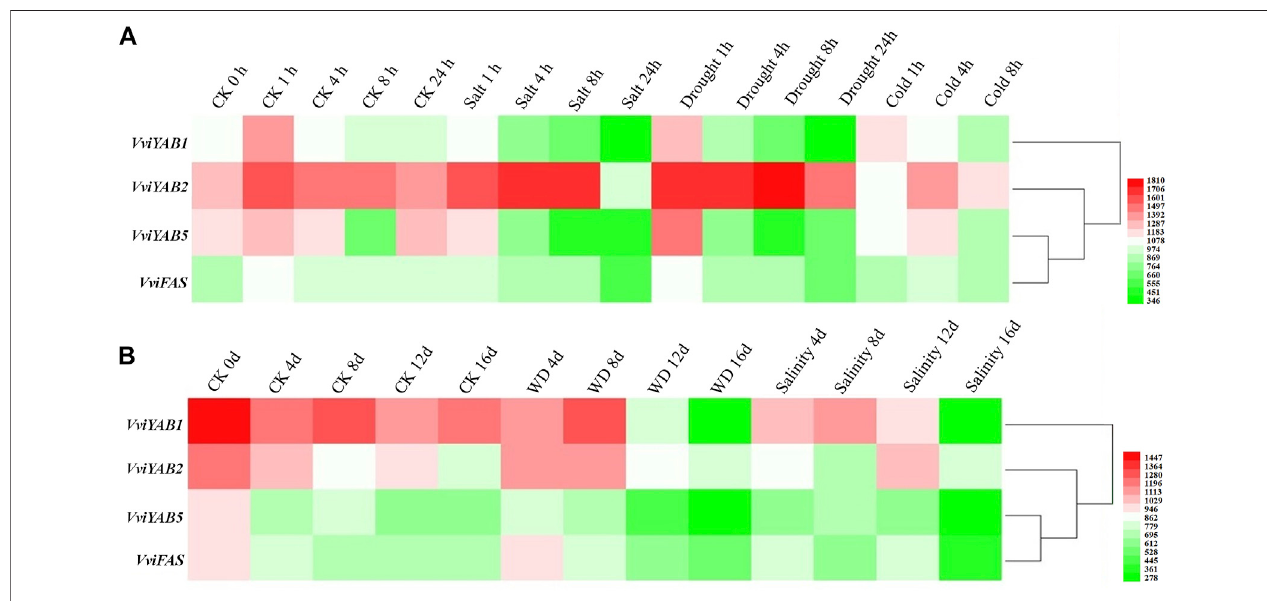
FIGURE 7 | Expression patterns of VviYAB genes in response to abiotic stresses. Microarray analysis of VviYAB genes in the V. vinifera cv. Cabernet Sauvignon were downloaded from the NCBI GEO datasets (GSE31594 and GSE31677) and graphically represented with MeV software. (A) V. vinifera cv. Cabernet Sauvignon plantsgrowninahydroponicdripsystemweretreatedwith120 mMsalt,polyethyleneglycol(PEG),cold(5 ° C),oruntreated.Shootswithleaveswerecollectedat0,1,4, and 8 h for all treatments and at 24 h for all treatments except cold (GEO series GSE31594). (B) Potted V. vinifera cv. Cabernet Sauvignon in the greenhouse were exposed to a water-de fi cit stress (WD) by withholding water or a salt stress by watering plants with a saline solution for 16 days. Non-stressed, normally watered plants served as the control for both treatments. Shoot tips were harvested every 4 days (0, 4, 8, 12, and 16 days) (GEO series